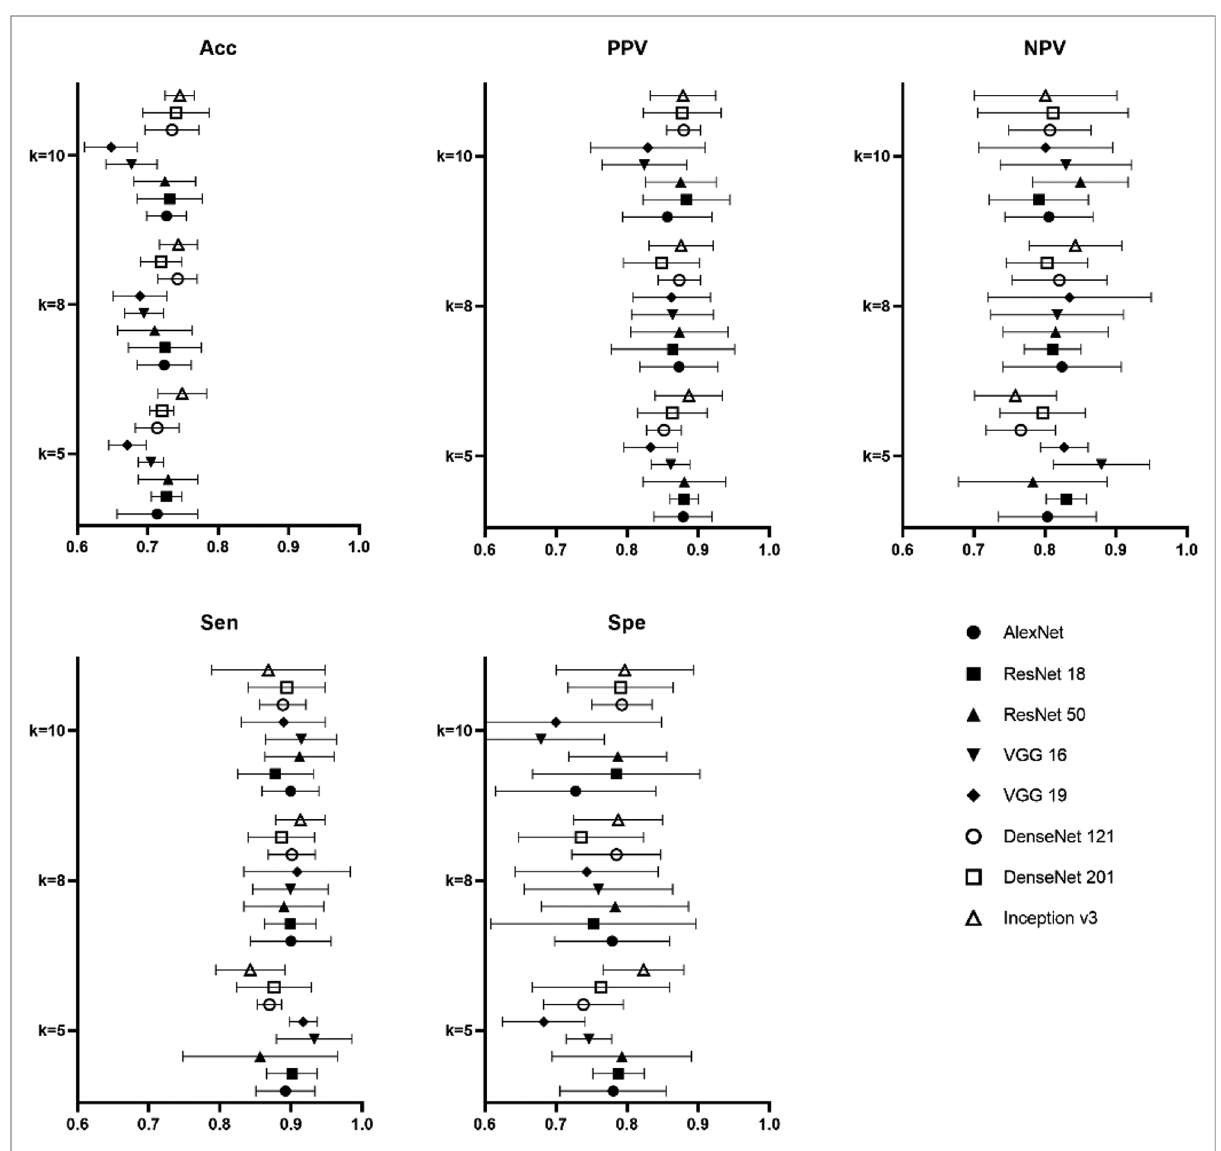
FIGURE 5 Result of performance metrics for the proposed 8 models in CAP severity classi fi cation for different k-folds cross